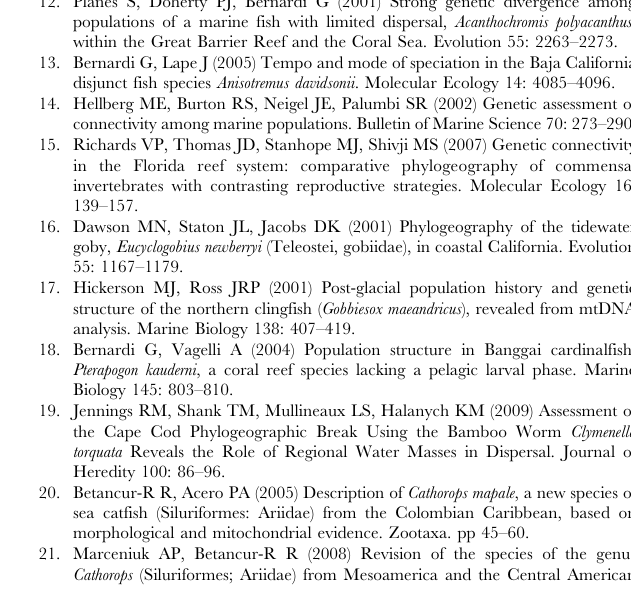
Text S1 Morphological material examined for the Cathorops mapale group. Locality abbreviations given in parentheses follow Fig. 1; two letter country codes follow ISO-3166.